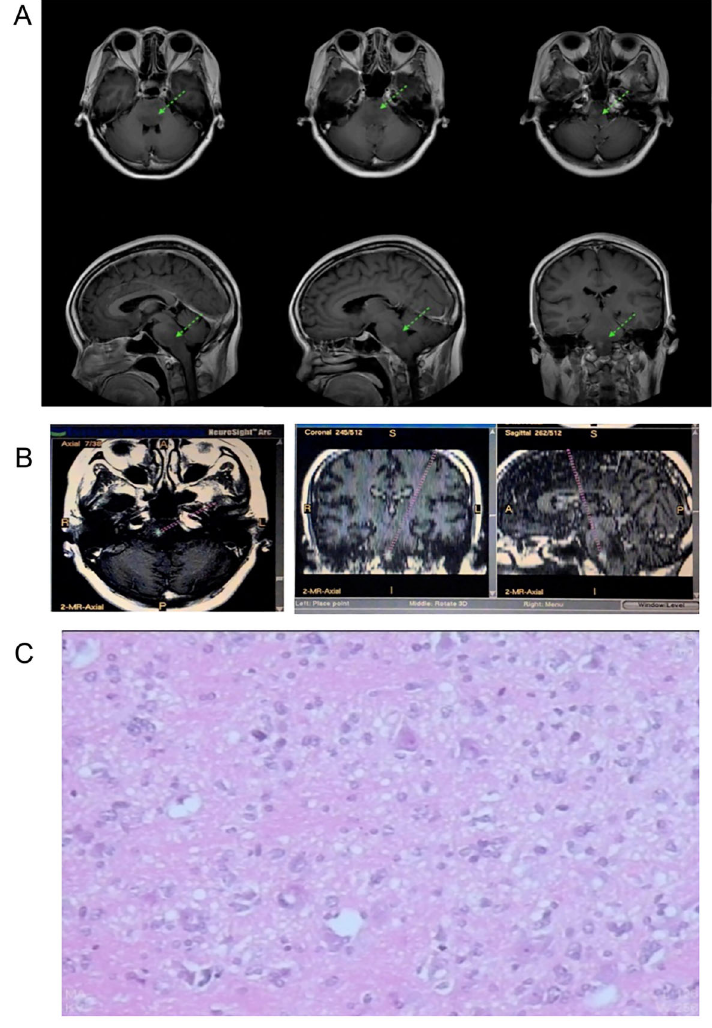
Figure 3 . Case 3. A , T1-weighted contrast-enhanced magnetic resonance imaging showed pons, pons-medulla abnormally low signal, and no obvious enhancement. B , Surgical planning for micro-targets across the midline and pons-medulla junction. C , Pathological diagnosis of WHO Grade III